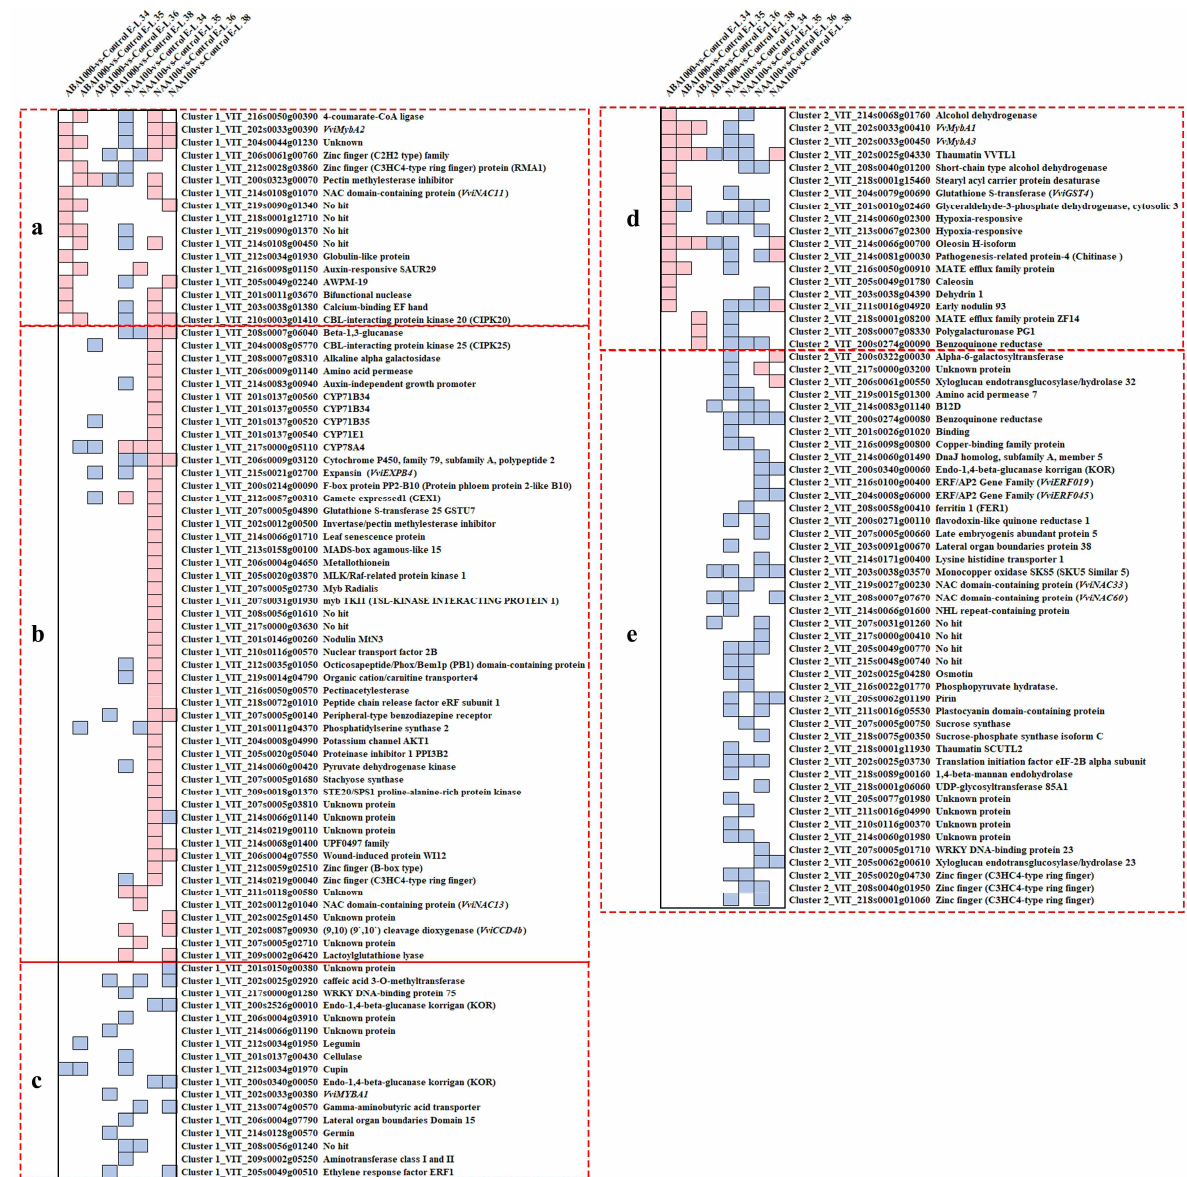
Figure 4. Differentially expressed switch genes between treatments and control. The significance of differentially expressed genes was judged based on the False Discovery Rate ≤ 0.01 and absolute value of log2Ratio ≥ 1. Blue and cyan boxes indicate significantly downregulated and upregulated genes in treated berries compared to the control, respectively. Genes were divided into groups ( a )–( e ) according to their different responses to the treatments.